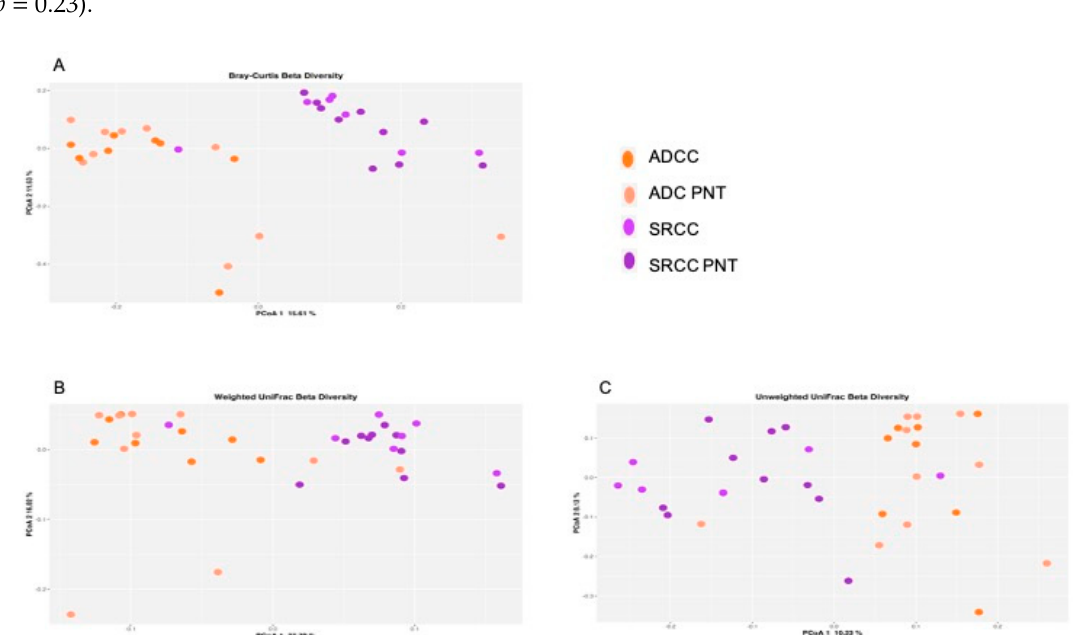
Figure 1. Principal coordinate analysis (PCoA) plot with Bray–Curtis dissimilarity. Results revealed significant differences between ADC (adenocarcinoma) and SRCC (signet-ring cell carcinoma) ( A ). Composition of the gut microbiota does not significantly change between ADC and SRCC samples; ( B ) unweighted and ( C ) weighted UniFrac measures of beta-diversity visualized using PCoA .